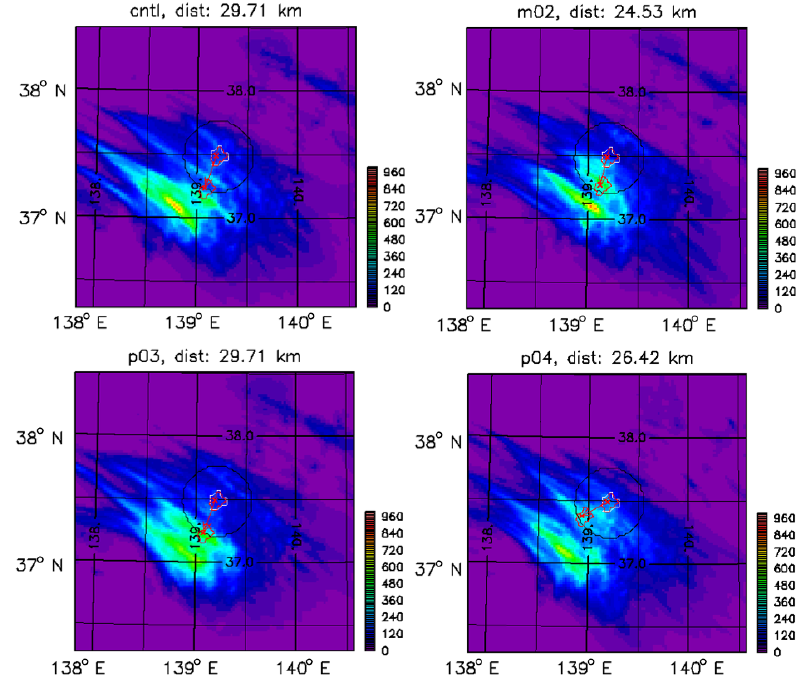
Figure 16. Examples of the position shifts of the ensemble